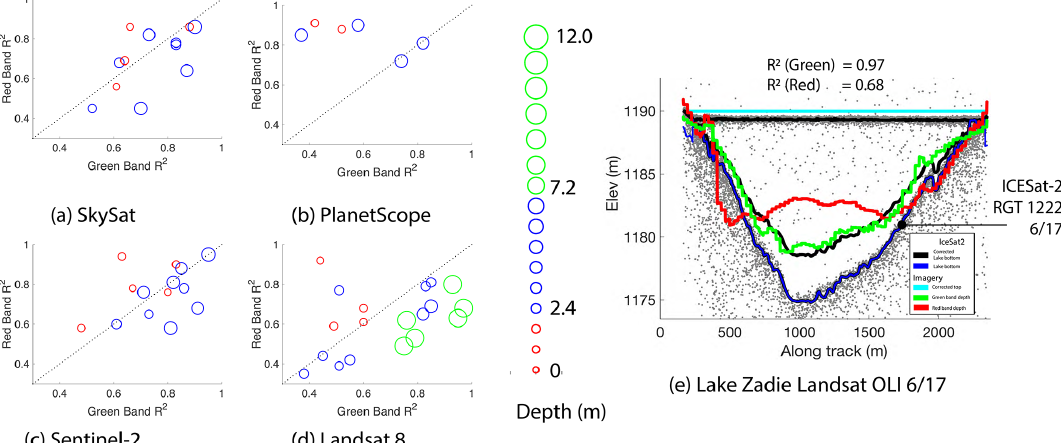
Figure 4. Comparing R 2 values from empirical estimates calculated with the red band vs. the green band from multiple imagery sources, with lakes classified by maximum lake depths as calculated by Watta. (a) Planet SkySat TOA reflectance. (b) Planet PlanetScope surface reflectance. (c) Sentinel-2 TOA reflectance. (d) Landsat 8 OLI TOA reflectance. (e) Watta-calculated and imagery-derived depths: Lake Zadie based on Landsat